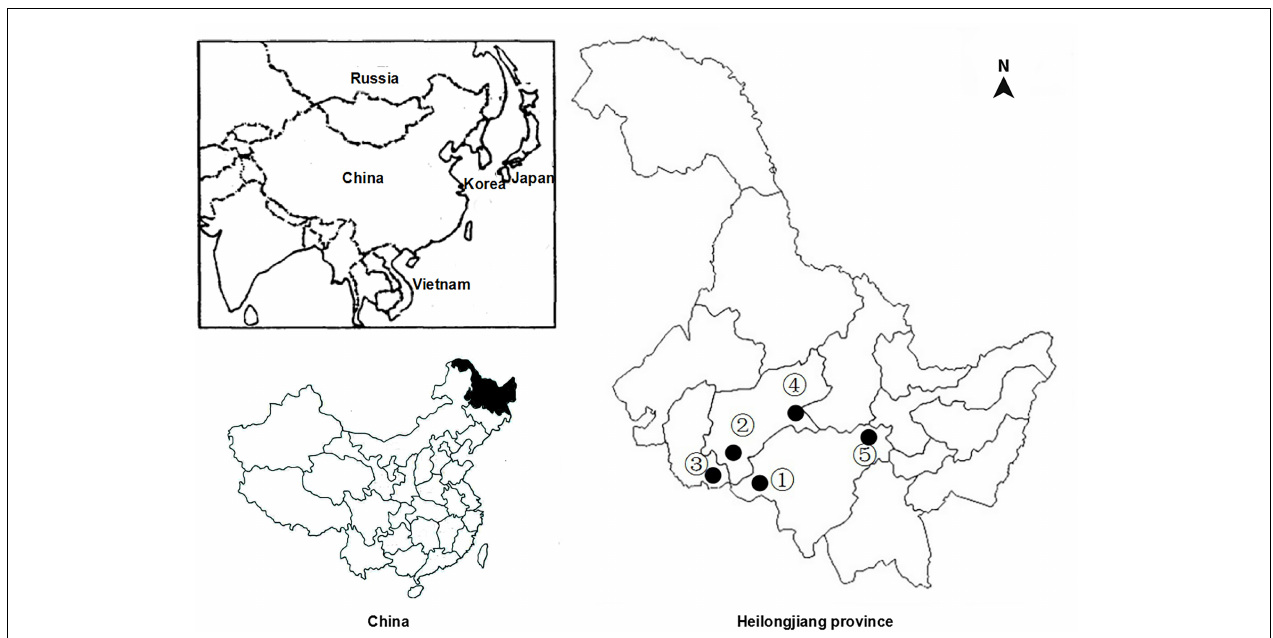
FIGURE 1 | Sampling locations for Clonorchis sinensis in heilongjiang province, China. Numbers correspond with those in Table 1